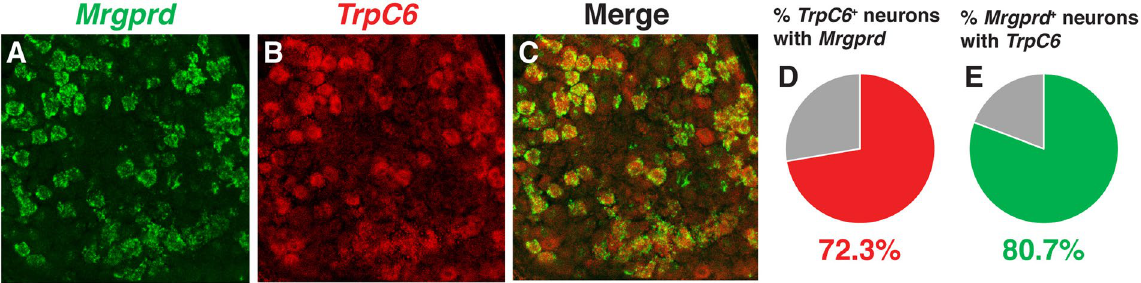
Figure 7. Expression of TrpC6 in DRG neurons compared to TrpC3 . ( A – E ) Double fluorescent in situ hybridization for Mrgprd and TrpC6 , along with percentage overlap quantification, in P21 WT mouse DRG thoracic